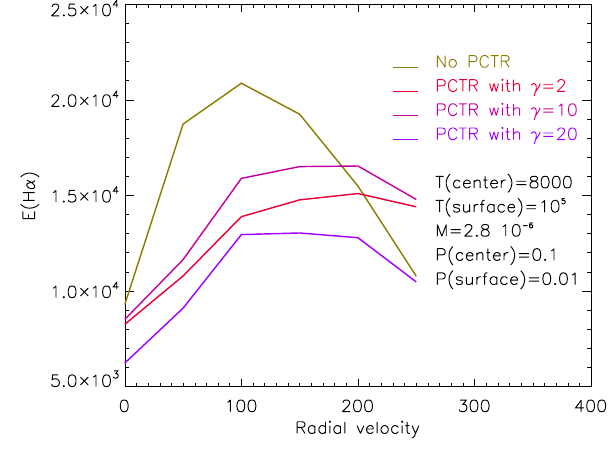
Fig. 3. Variation of the He I λ 584 ˚ A line intensity (in − 1 ergs − 1 cm − 2 sr − 1 ˚A ) as a function of the radial velocity of the prominence plasma (in kms − 1 ) for 4 different types of prominence atmospheres.